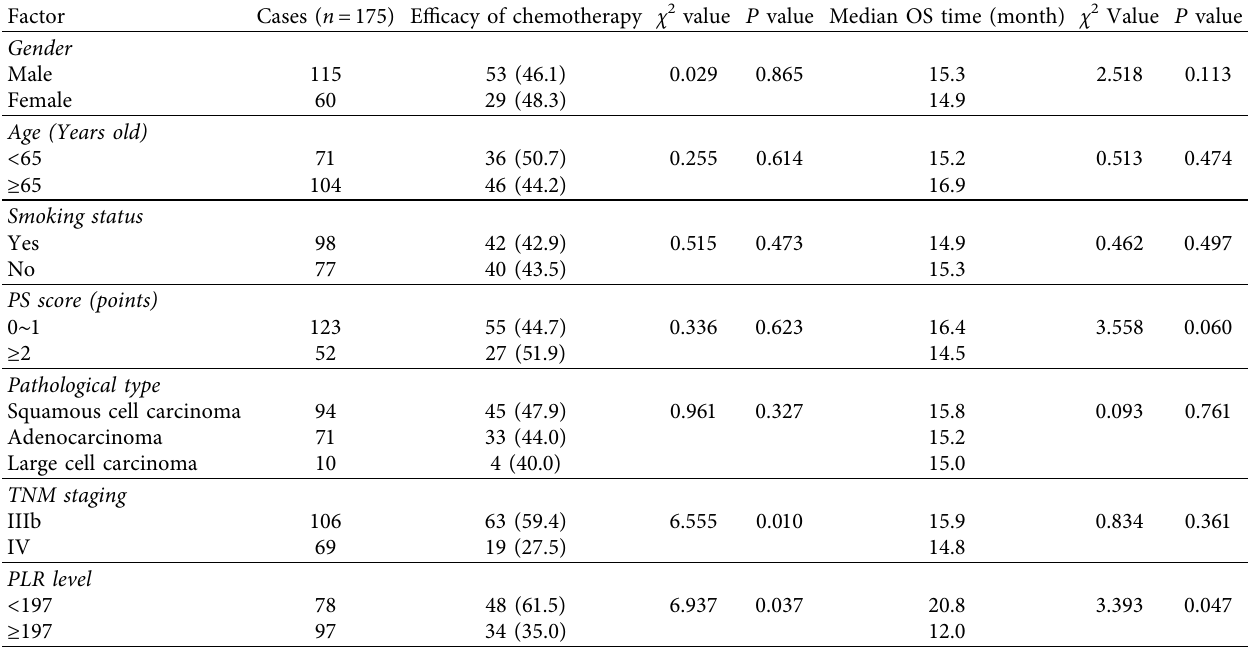
Table 2: Comparison of effective rate and OS time in patients with advanced NSCLC ( n , %). Factor